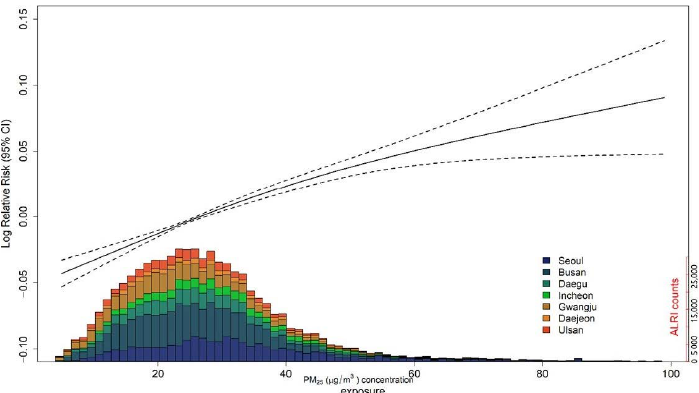
Figure 2. Exposure–response relationship between short-term PM 2.5 concentrations and ALRI hospital admissions in children in seven metropolitan cities in Korea. The gray shade indicates the 95% confidence interval. The figure below shows the ALRI hospital admission distribution over PM 2.5 concentrations. All models used the 7-day moving average exposure to PM 2.5 μg/m 3 . The percentage change is calculated as the change per PM 2.5 10 μg/m 3 increase.